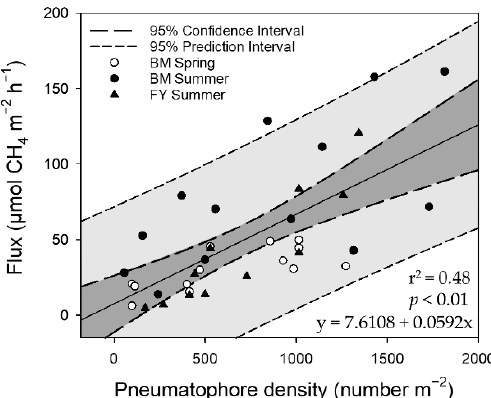
Figure 7. The relationships between the pneumatophore density and CH 4 flux for the A. marina mangroves: E2 — Fangyuan (FY); G — Beimen (BM).